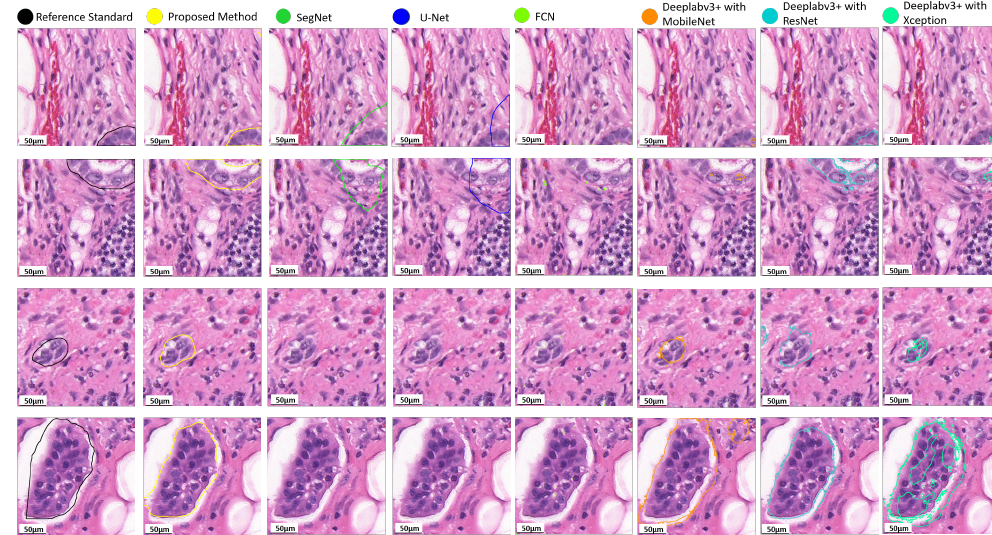
Figure 5. The box plot of the quantitative evaluation results in metastasis segmentation, where the outliers > 1.5 × the interquartile range are marked with a dot. The results of the LSD tests ( p < 0.001) show that the proposed method significantly outperforms the baseline approaches.